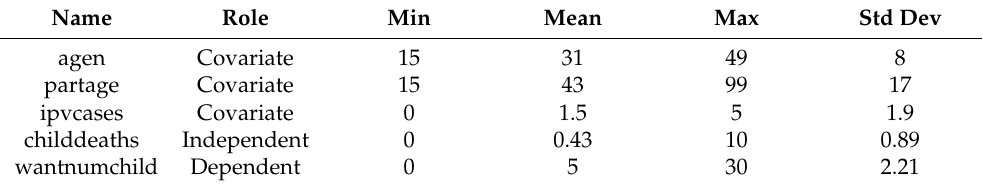
Table 1. Integer/count covariates and variable of interest (Liberia 2013; Ghana 2014; Senegal